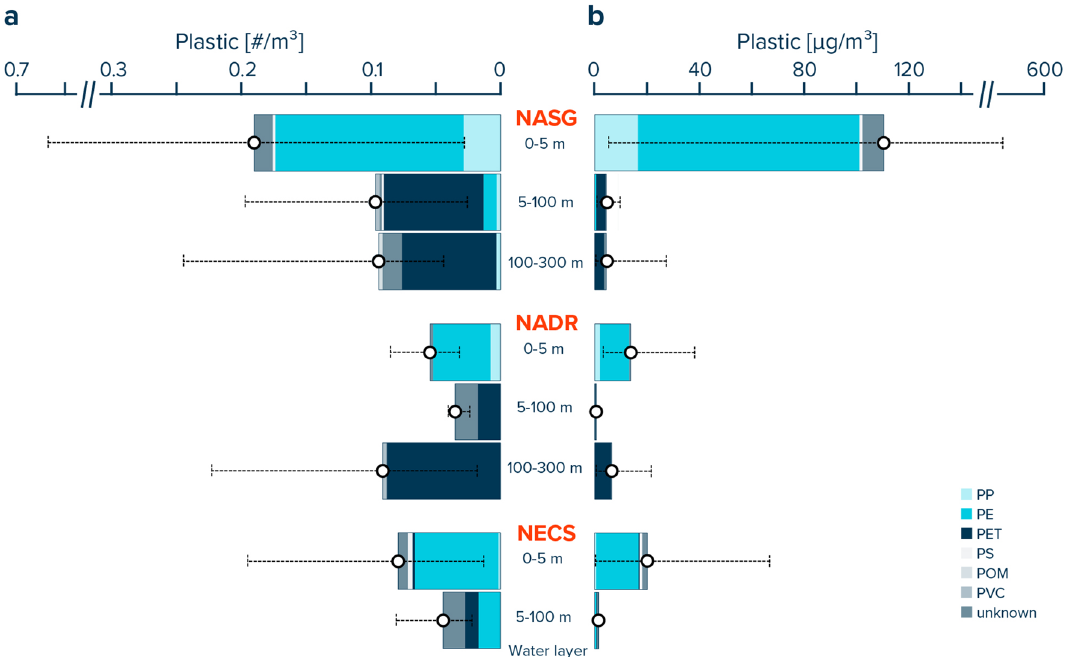
Figure 3. Vertical distribution of ( a ) numerical and ( b ) mass concentrations of plastic debris (0.05–5 cm in size) for specific water layers in the eastern North Atlantic Ocean and corresponding polymer composition. White dots represent average values and whisker extend to the smallest and largest concentrations measured in the respective depth layer. NASG North Atlantic Subtropical Gyre, NADR North Atlantic Drift Region, NECS Northeast Atlantic Continental